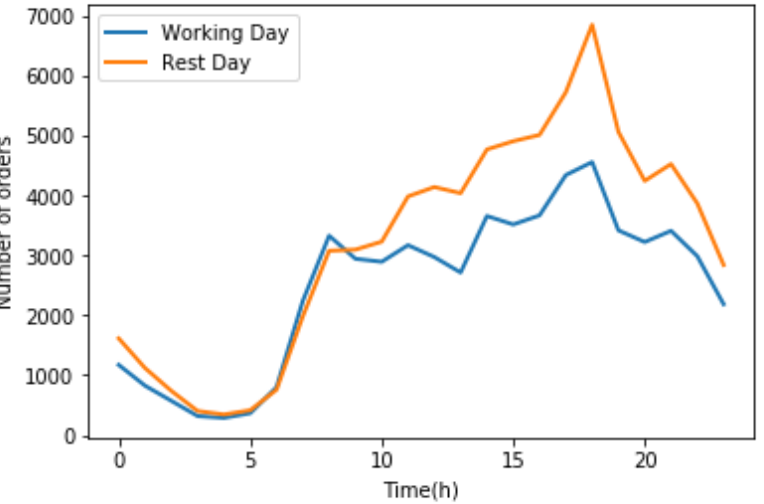
Figure 4. Time distribution of online car-hailing travel orders.